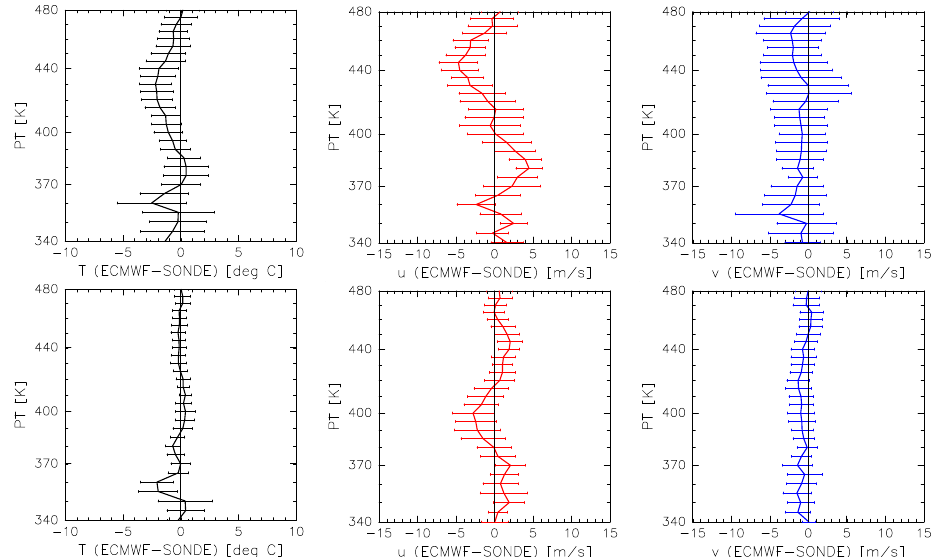
Fig. 4. Ensemble mean differences of (left) temperature and (centre) zonal and (right) meridional wind components between radiosonde observations and ECMWF analysis illustrated as a function of potential temperature. Estimations are made by using SOWER station data at Tarawa, Biak, Bandung and Kototabang for the period (top) before and (bottom) after December 2006. The horizontal bars correspond to the confidence interval of 99%.